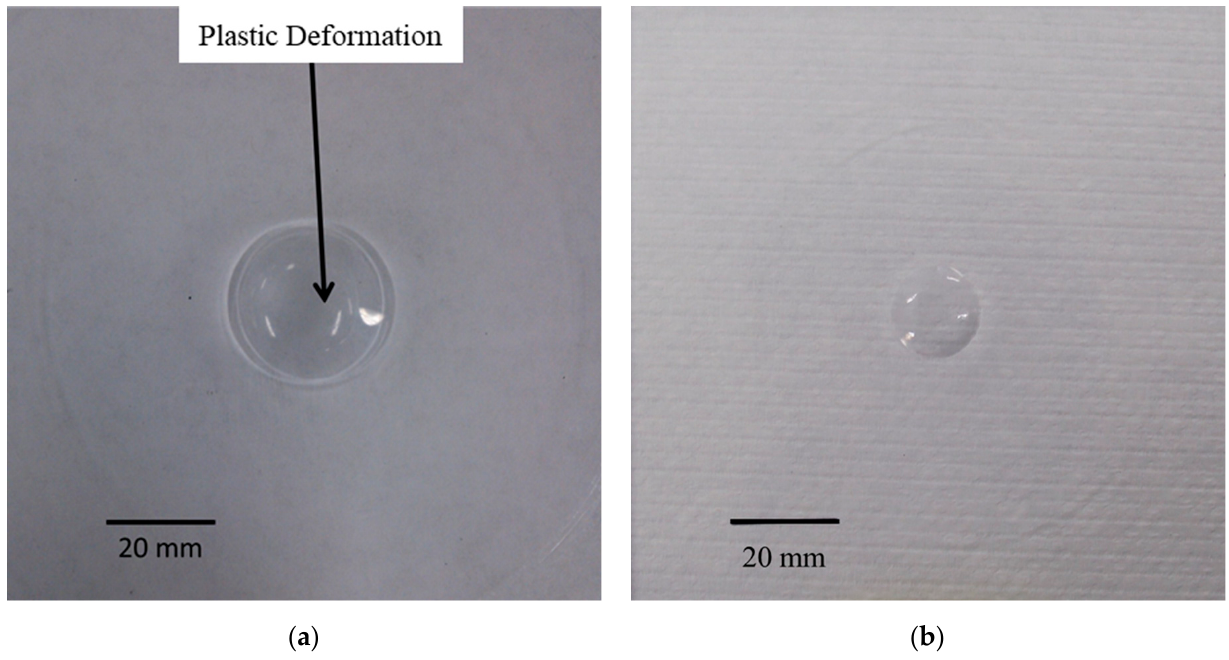
Figure 10. Plastic deformation on a baseline PC specimen after impact ( a ) top view and ( b ) bottom view.